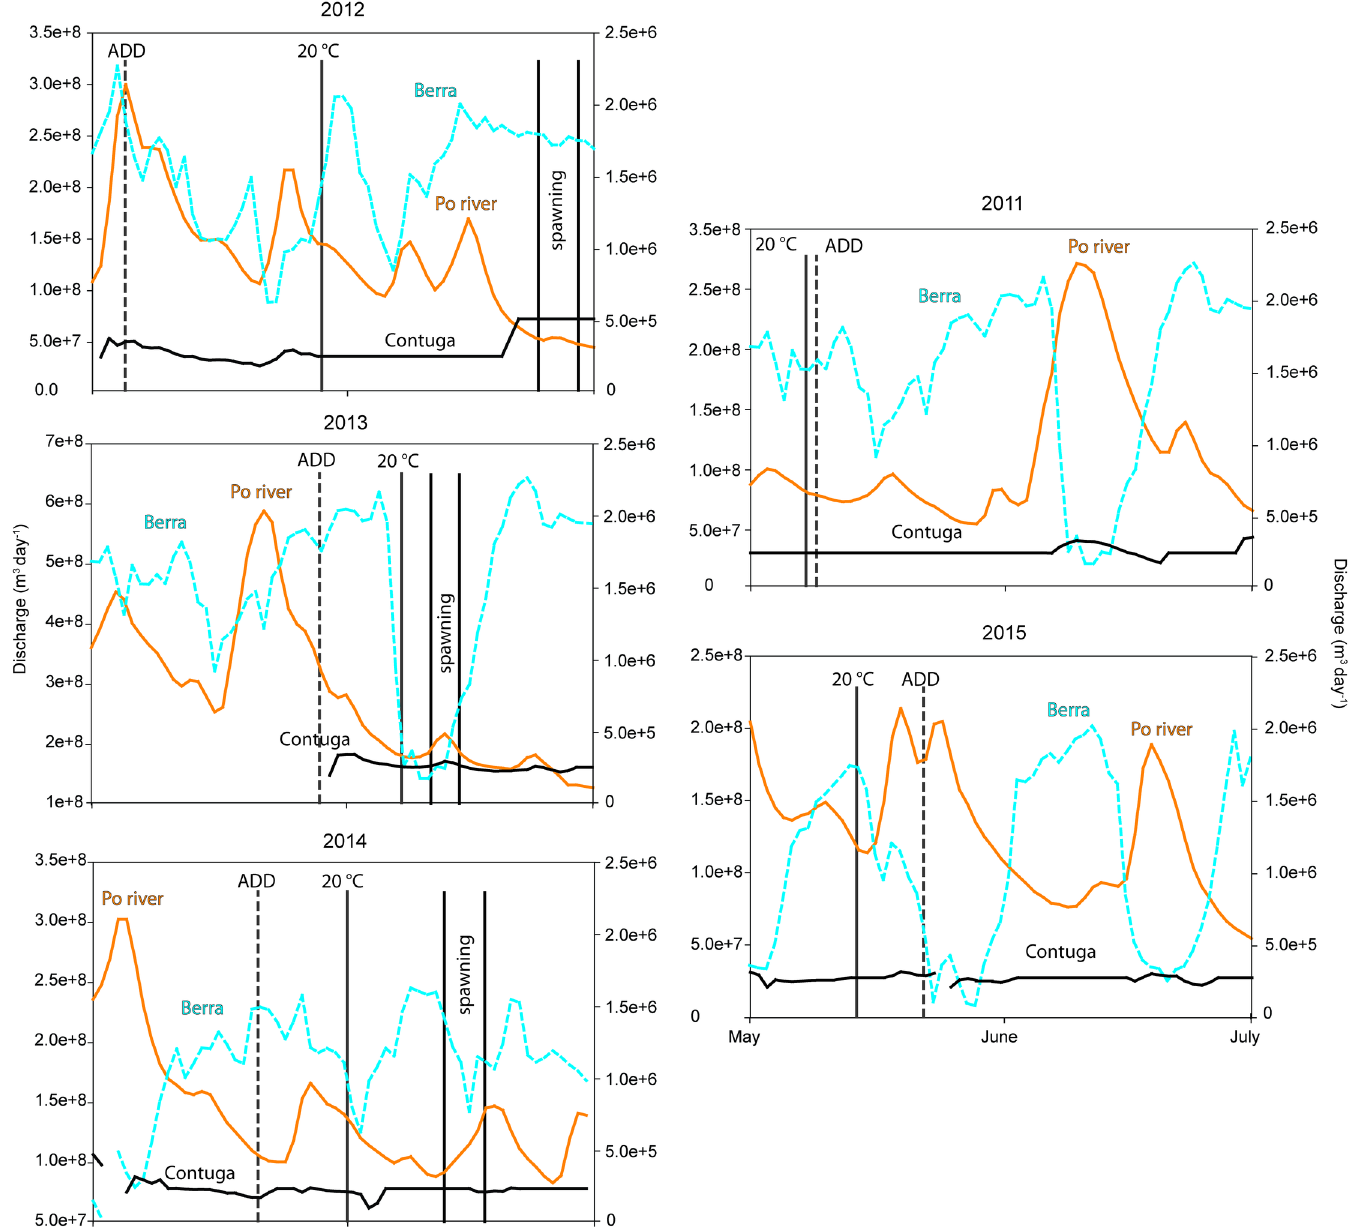
Fig 3. Hydrographs of the discharge in the main river (in solid orange, left Y axis), the Contuga siphon (in solid black, right Y axis) and the Berra siphon (in dashed blue, right Y axis). Vertical lines represent the ADD15 (dashedgrey) threshold,first day of 20˚C (solid gray) and estimated fertilization dates (solid